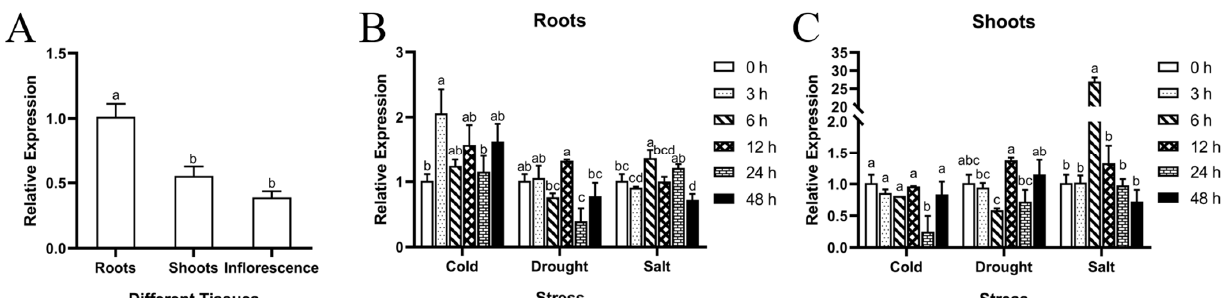
Figure 2. Expression analysis of MsVDAC in alfalfa: ( A ) Tissue-specific expression of MsVDAC in alfalfa roots, leaves and inflorescences; ( B ) Expression pattern of MsVDAC in alfalfa roots under cold, drought and salt stress; ( C ) Expression patterns of MsVDAC in alfalfa leaves under cold, drought and salt stress. The error bars represent the means ± SDs of three independent biological replicates. The different letters represent significant differences ( α = 0.05).